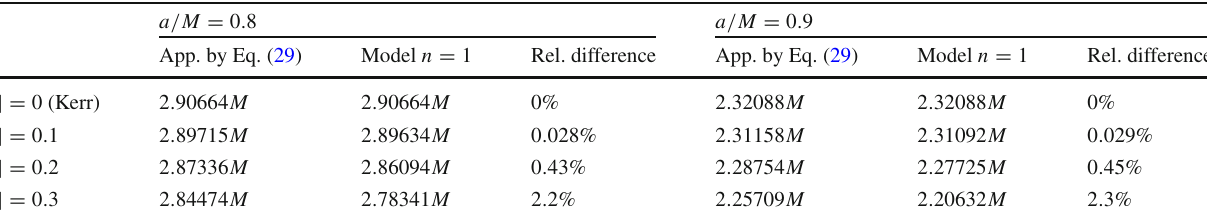
Table 1 The values of prograde ISCO radii obtained from the approx- relativedifferencebetweenthevaluesobtainedfromthetwoapproaches imated formula (29), in which the deviation function remains quite is calculated arbitrary, and those obtained from our specific model with n = 1. The a / M = 0 . 8 a / M = 0 .